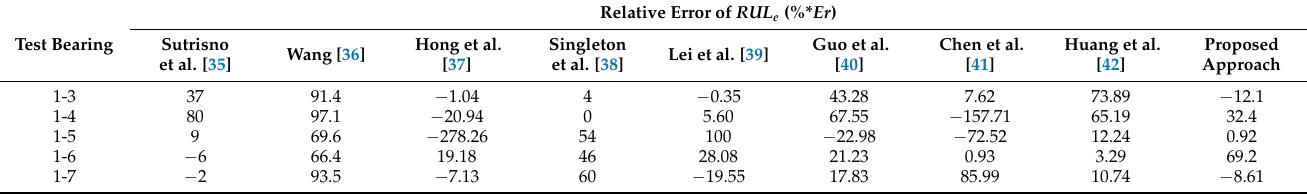
Table 9. Comparison of relative errors of the proposed approach with the previous solutions.